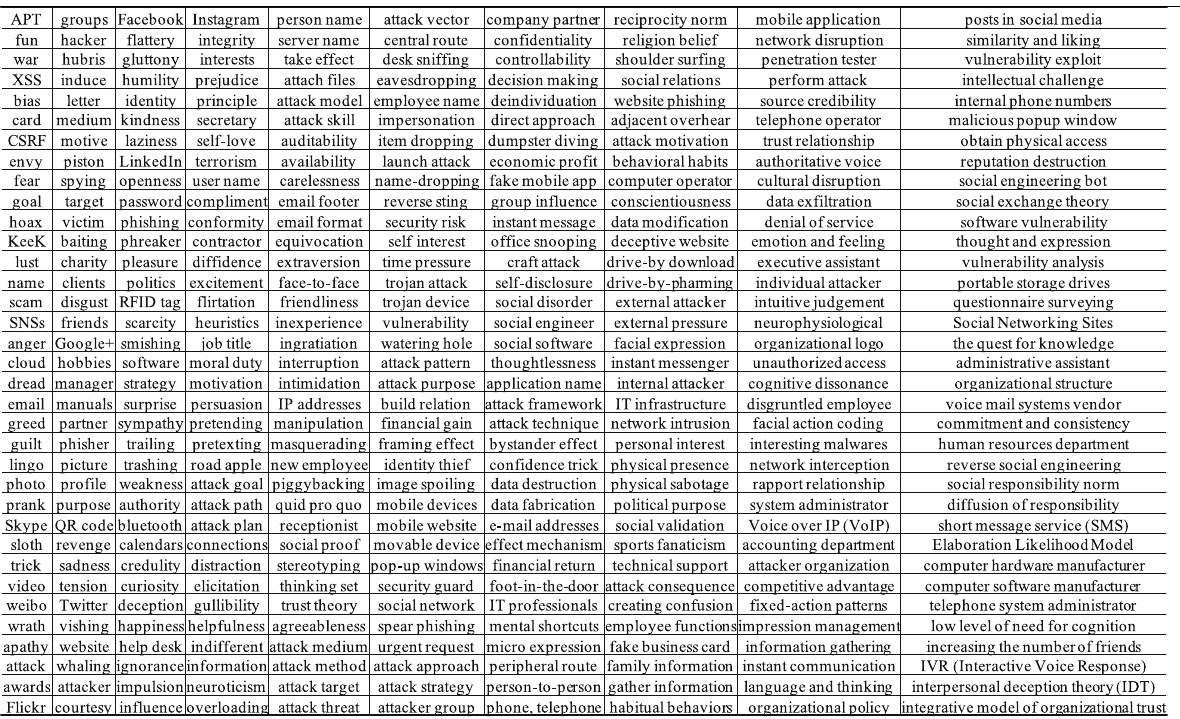
Table 1 Terms related to social engineering in